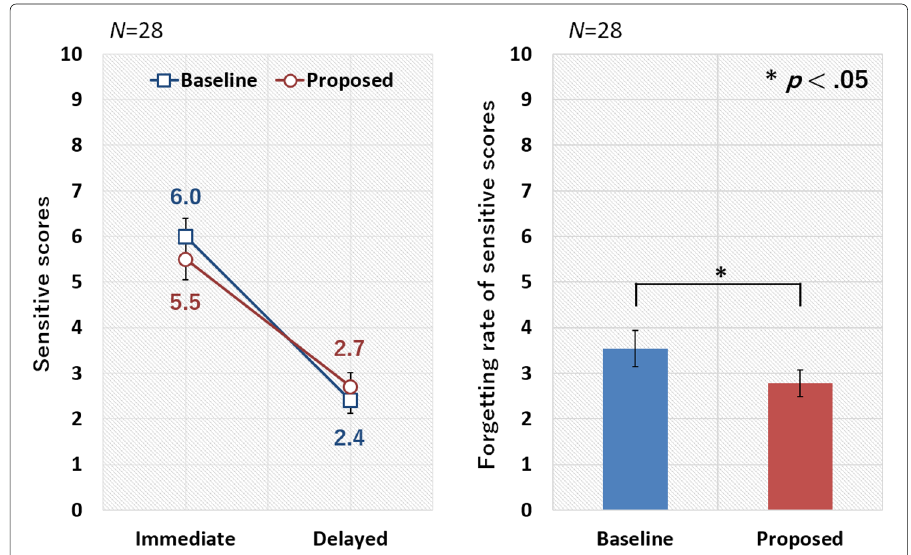
Fig. 6 Left: Average of the sensitivity scores in the immediate and delayed tests. Right: Forgetting rate of this score under the baseline and proposed methods. The error bar means standard error